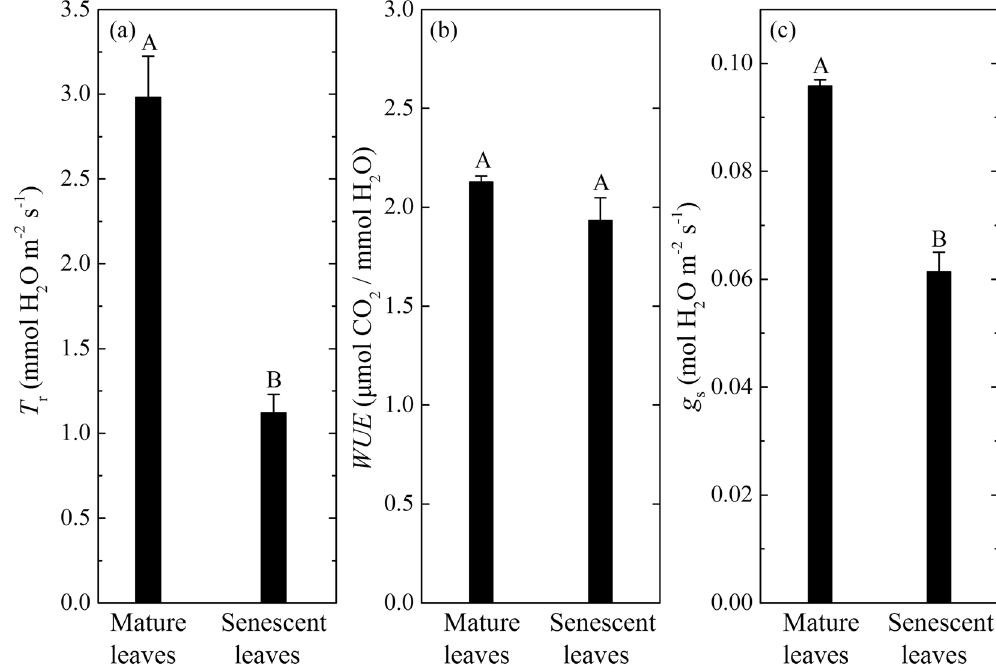
Figure 4. Comparison of leaf transpiration rates ( T r ), water use efficiency ( WUE ), and leaf stomatal conductance ( g s ) at light saturation point between mature green leaves (July to August) and senescent red leaves (late October to December). Values are averages ± SE (n = 3 days for mature leaves, n = 9 days for senescent leaves). Different uppercase letters on the top of the bars mean significant differences at P = 0.01 level between the mean values for mature and senescent